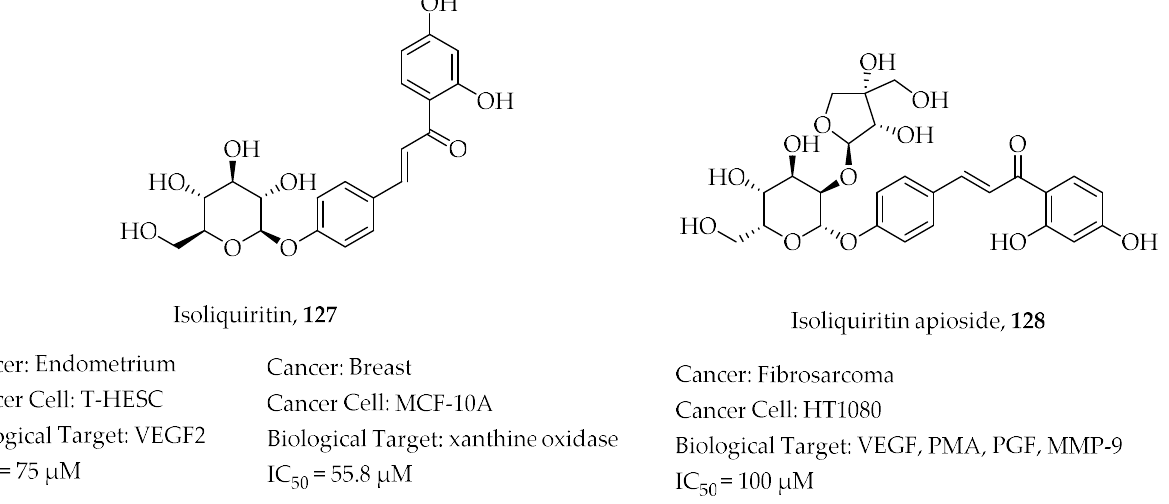
Figure 23. Structures of the flavonoid glycoside Isoliquiritin and its biosynthesized derivative isoliquiritin apioside with a summary of their biological activity towards selected cancer targets.